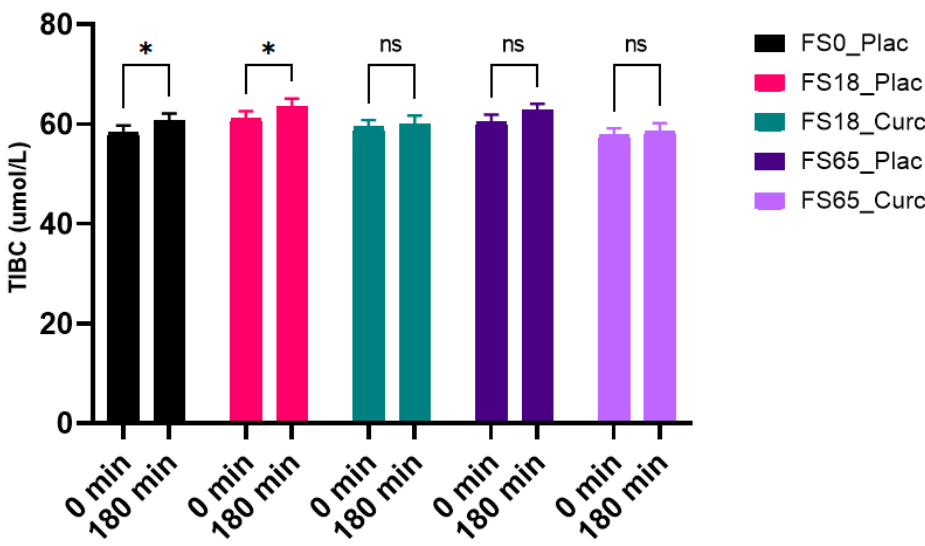
Figure 3. Effect of 180 min supplementation on mean serum total iron binding capacity (TIBC, µmol/L) levels (mean, SEM). * represents significance values when comparing time points within the same conditions (* p < 0.05); ns indicates no significant difference ( p > 0.05).